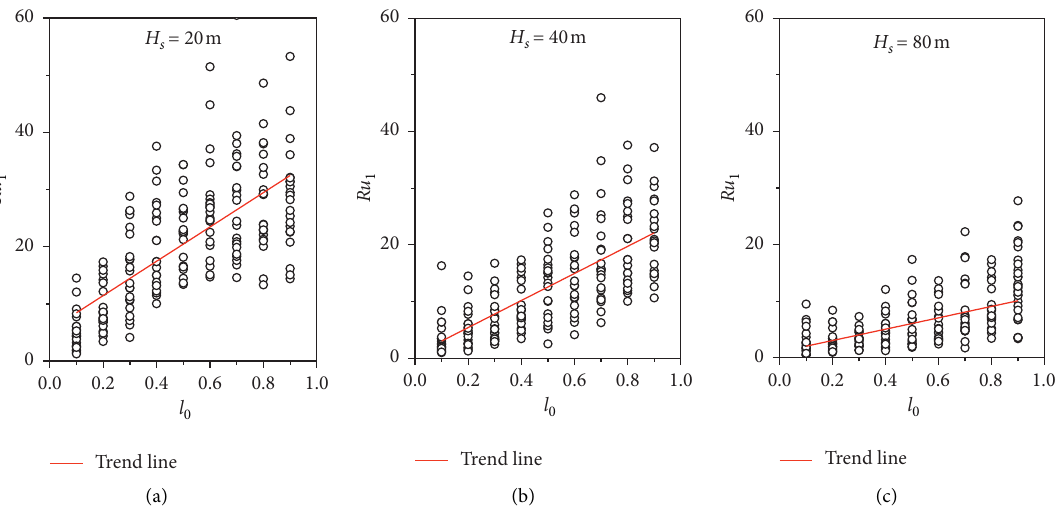
Figure 17: The parameters Ru